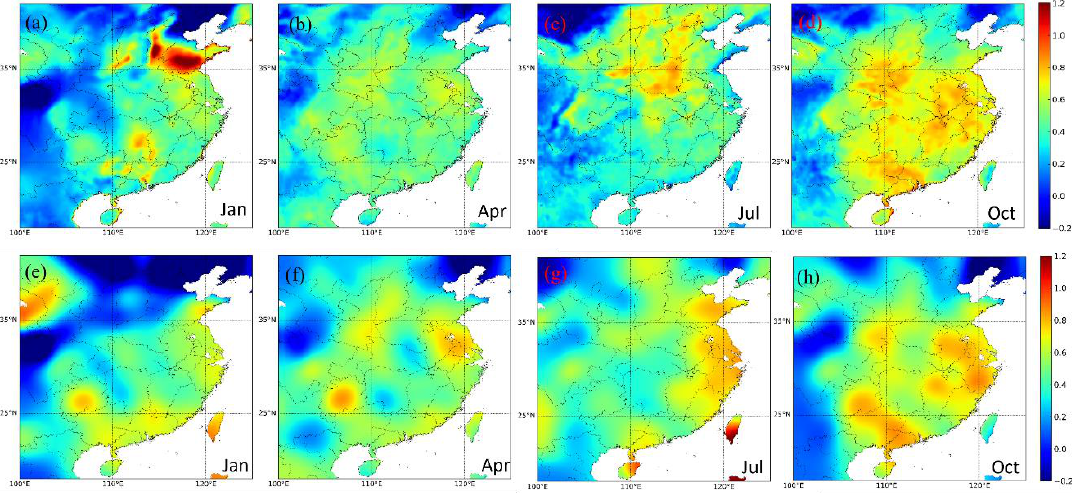
Figure 3. Monthly spatial distribution of aerosol characteristics γ′, ( a – d ) are derived from WRF-Chem model data; ( e – h ) are derived from SEM.